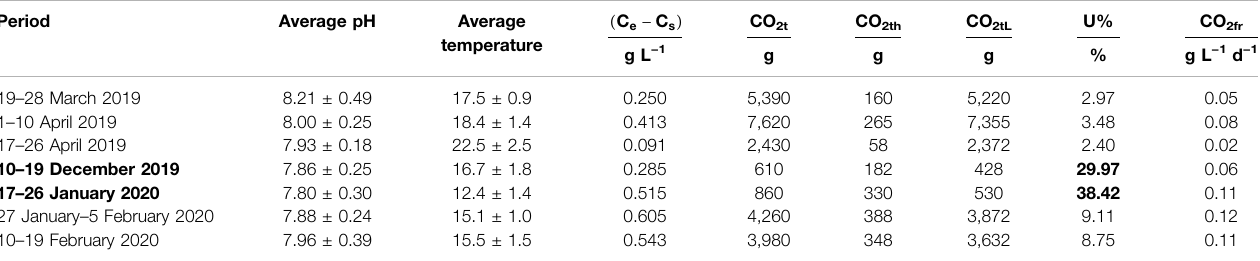
TABLE 3| Overview ofthe total CO 2 injected during each batch growth test, pH was set at 8, and CO 2 was injected on demand tomaintain asteady pH. The twoperiodsin bold show the highest CO 2 utilization ef fi ciency. Period Average